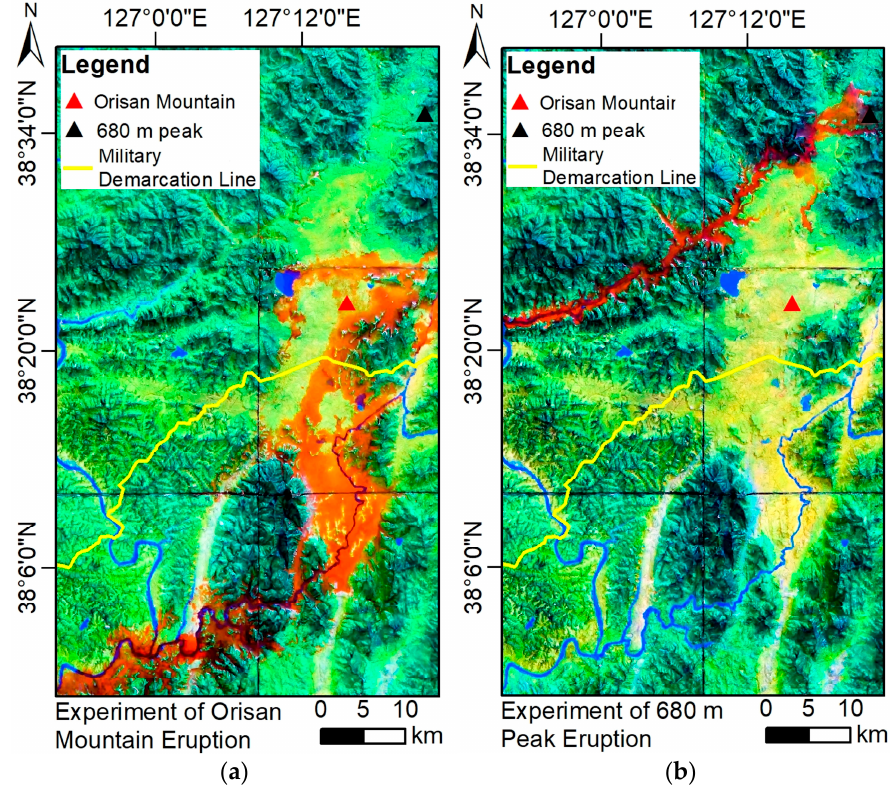
Figure 6. Experimental results of the lava flow simulation using the 3D-printed model from the ( a ) Orisan Mountain eruption and ( b ) 680 m peak eruption. The yellow line represents the boundary between South Korea and North Korea.